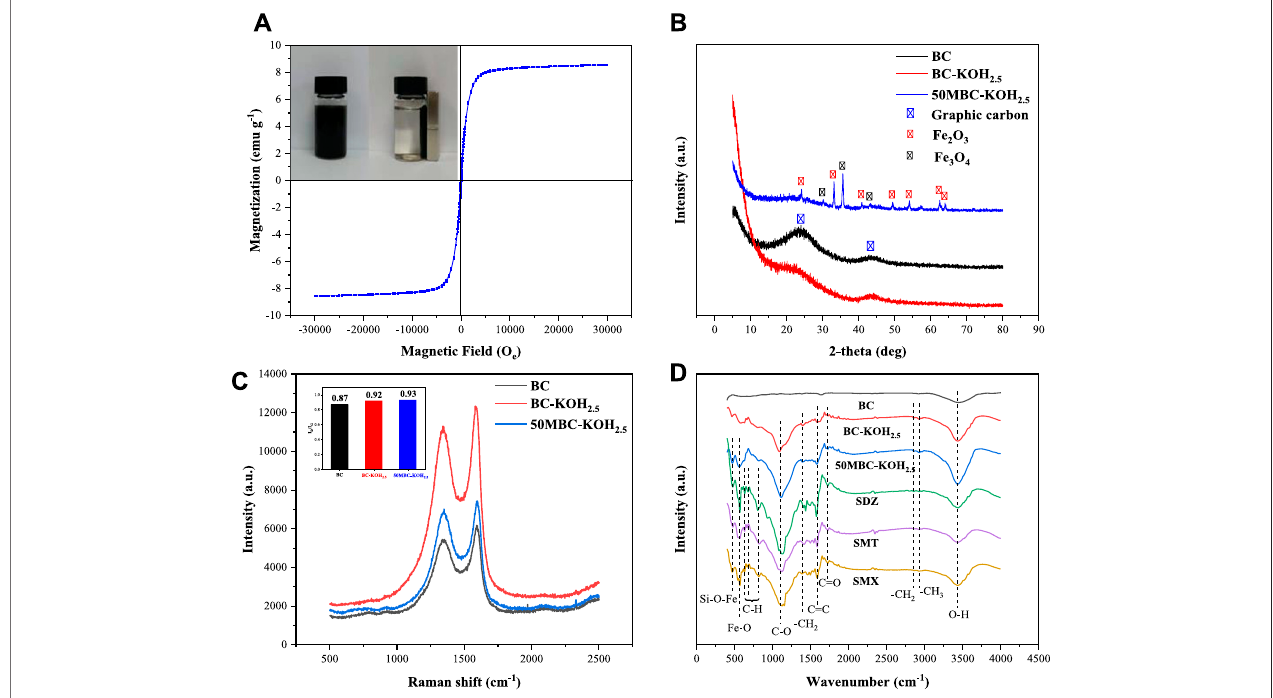
FIGURE 2 | (A) Magnetization curve of 50MBC-KOH 2.5 and photograph of magnetic separation of 50MBC-KOH 2.5 . (B) XRD patterns and (C) Raman spectra of BC, BC-KOH 2.5 and 50MBC-KOH 2.5 . (D) FTIR spectra of three adsorbents, and of 50MBC-KOH 2.5 after adsorption of SDZ, SMT and